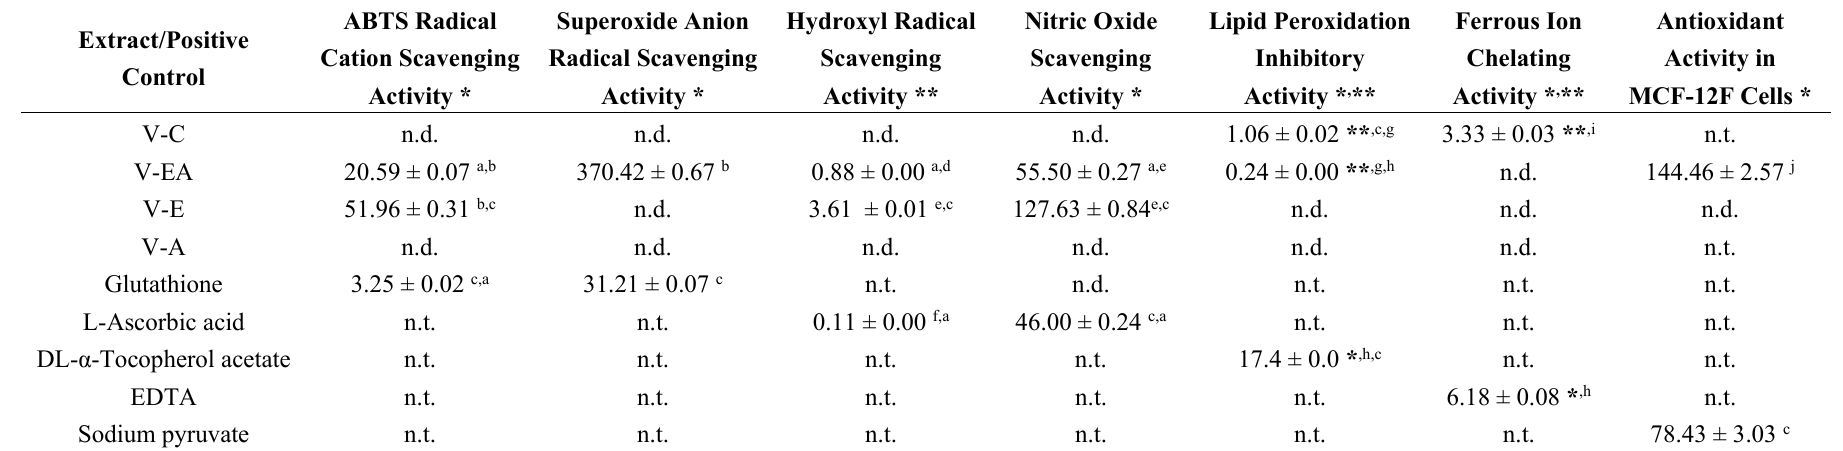
Table 1. EC 50 values of Vernonia kotschyana root extracts in different antioxidant